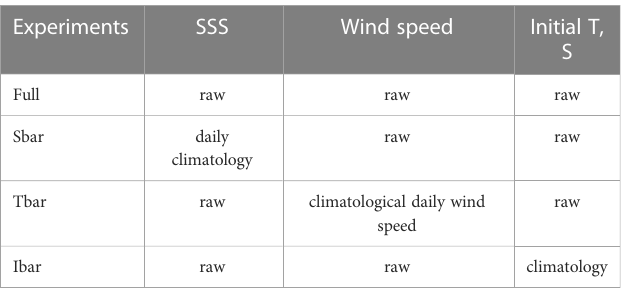
TABLE 1 The conditions for each of the